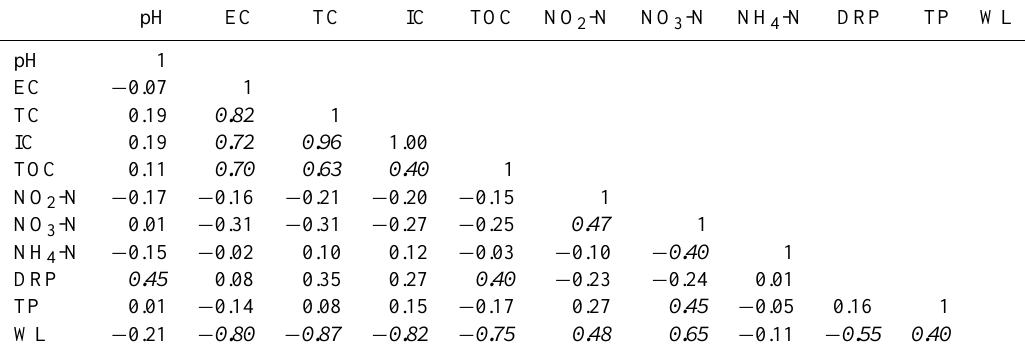
Table 2. Pearson’s correlation coefficient between the chemical species, physical parameters, and water level.